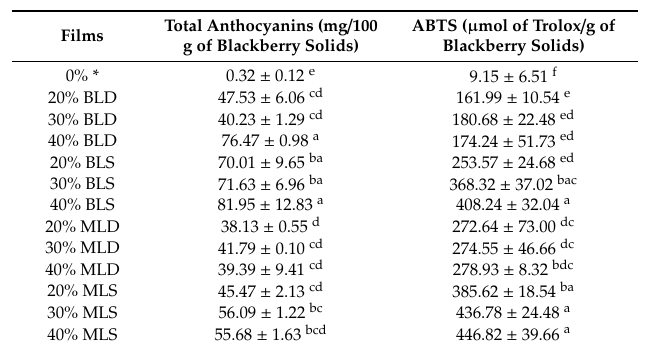
Table 3. Anthocyanins content and antioxidant capacity of films with 0%, 20%, 30% and 40% of freeze-dried blackberry pulp (BL) and freeze-dried microencapsulated blackberry pulp (ML) incorporated directly (D) and by sprinkling (S). Results of the control film characterization (0%) were published by Nogueira, Fakhouri and Oliveira